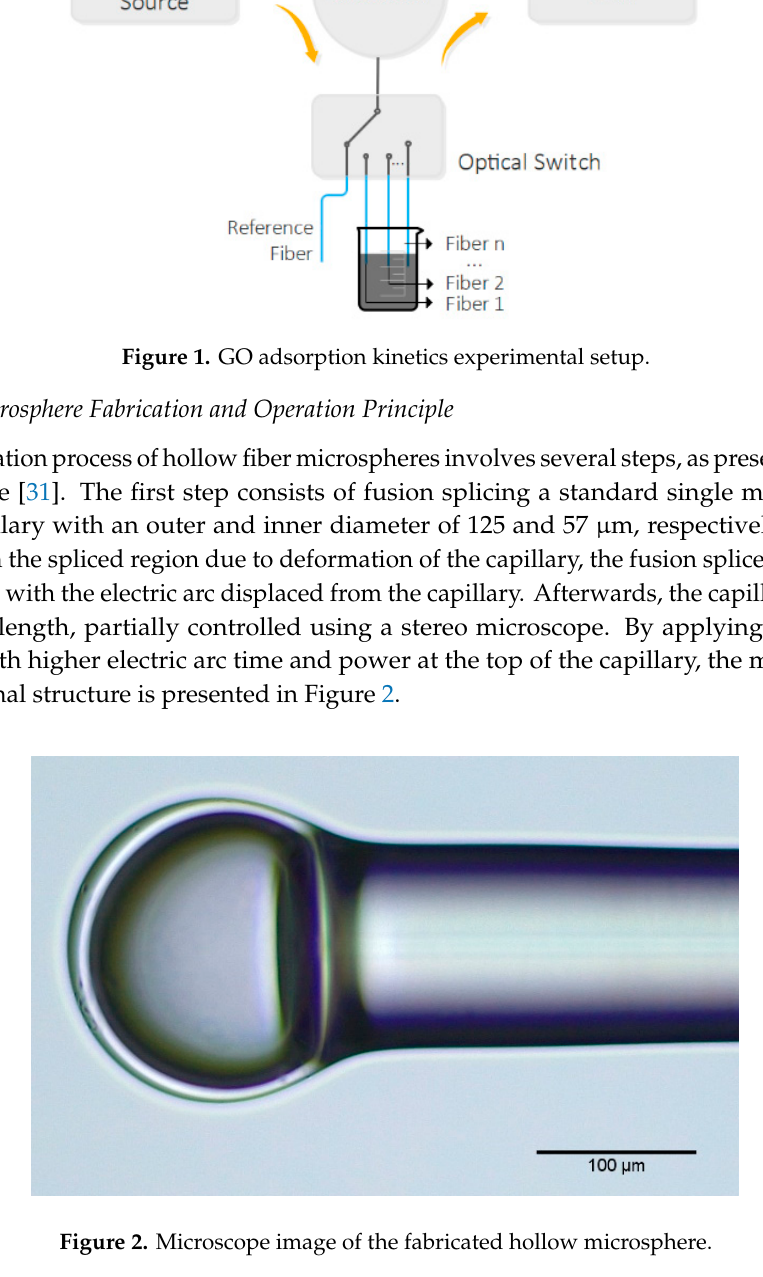
Figure 2. Microscope image of the fabricated hollow microsphere.